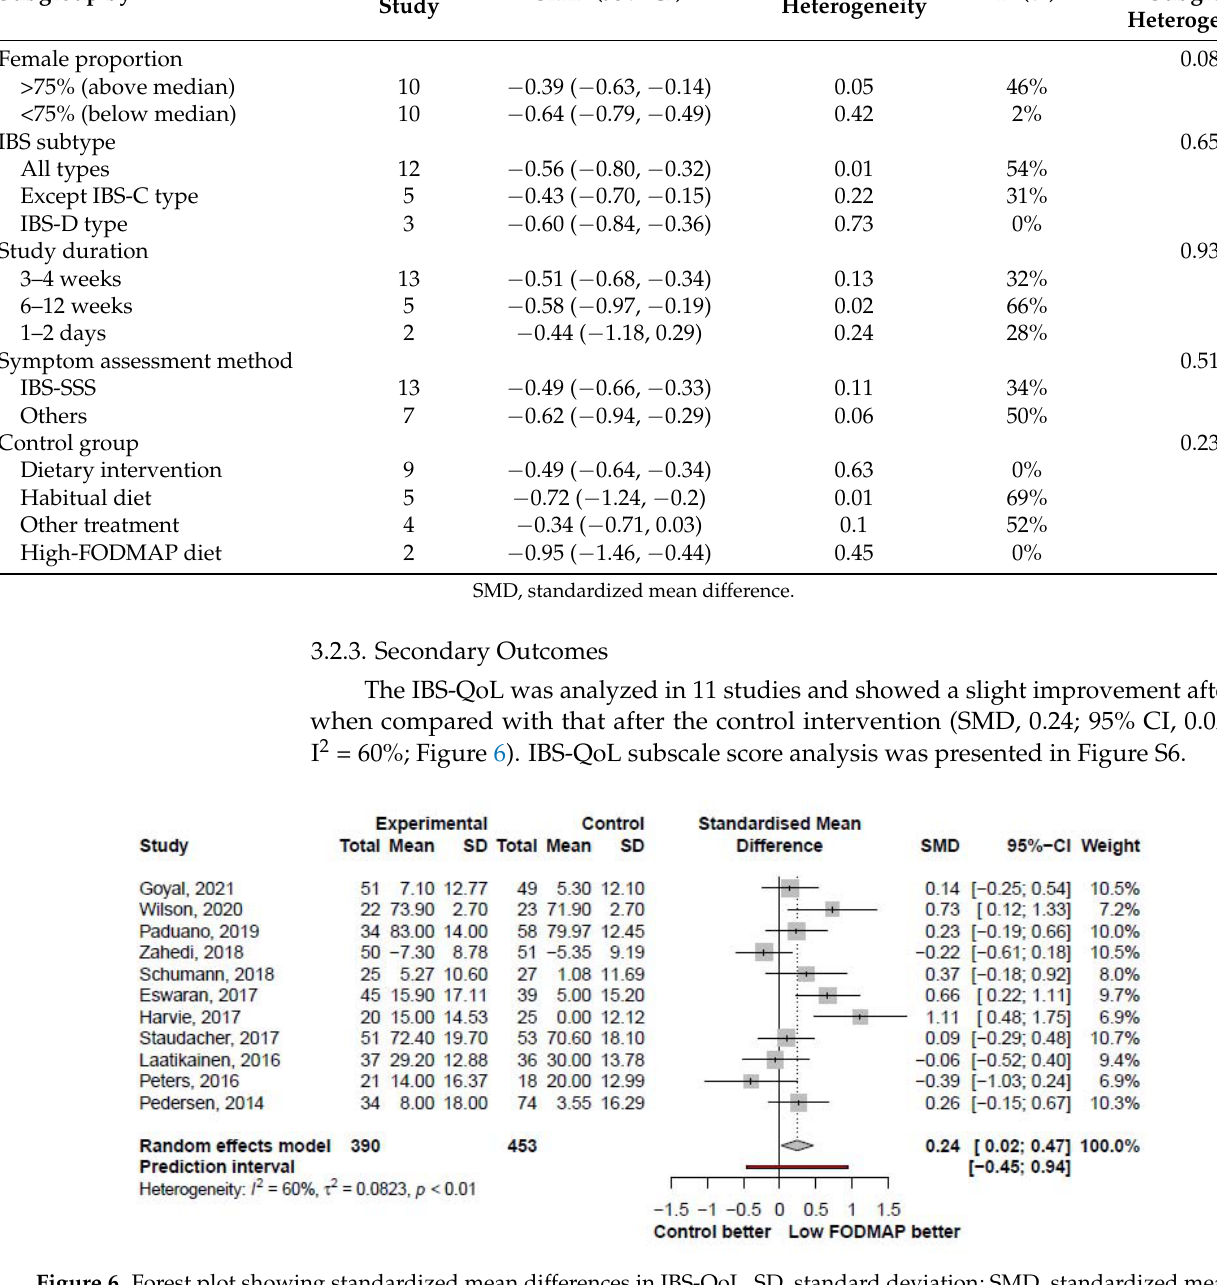
Figure 7. Forest plot showing mean differences in average weekly stool frequency. SD, standard deviation; MD, mean difference; CI, confidence interval. Figure 8. Forest plot showing mean differences in BSFS. SD, standard deviation; MD, mean difference; CI, confidence interval.